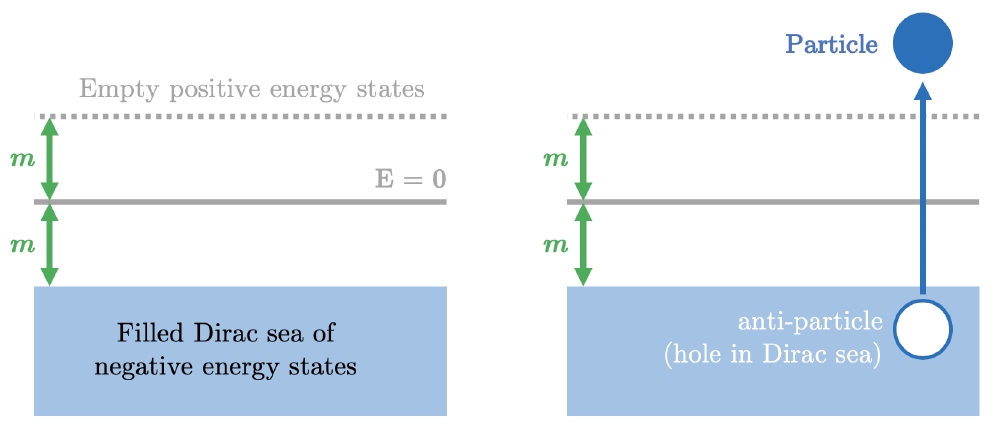
Figure 6: Left: the vacuum, with positive energy states empty and negative energy states fully occupied; Right: creation of a particle-antiparticle pair from the